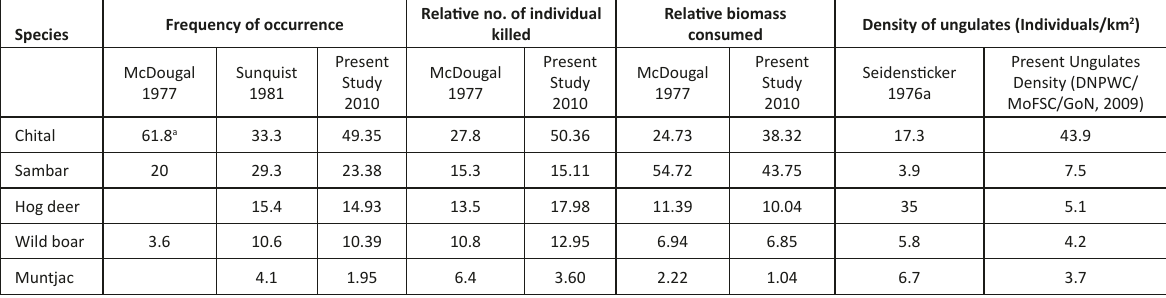
Table 3. Comparison of frequency of occurrence, relative no. of individuals killed, relative biomass killed and density of ungulates of Chitwan National Park at different time frames.